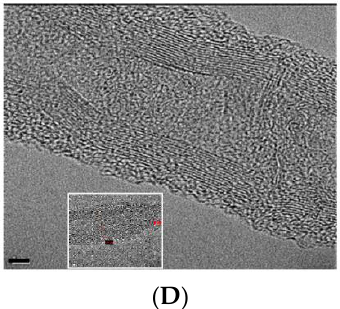
Figure 3. ( A ) Schematic of screen-printed electrodes modified with gold nanoparticles and subsequent Figure surface modification (reprinted with permission from [60]); ( B ) schematic of TiO 2 /3Dgraphene/polypyrrole aptasensor for lysozyme detection together with SEM and TEM images of the nanocomposite (reprinted